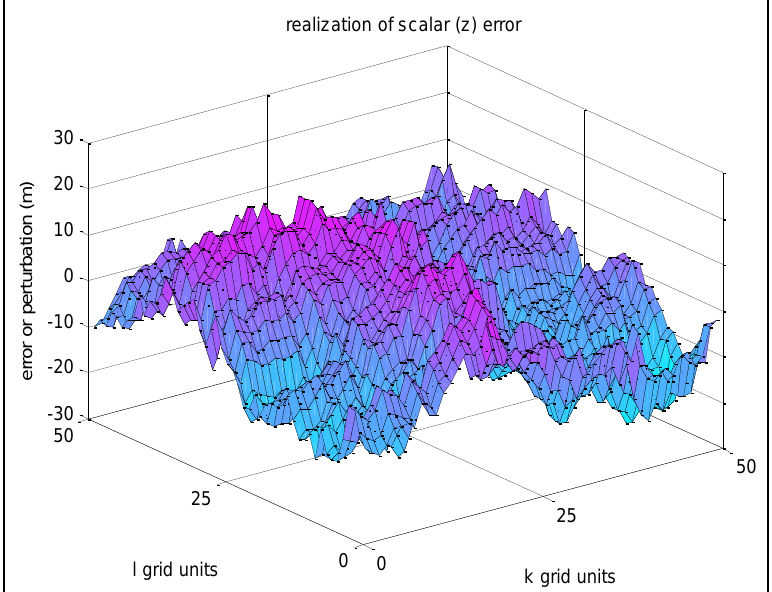
Figure 4. Example 1—Realization of -error with high spatial correlation between adjacent grid